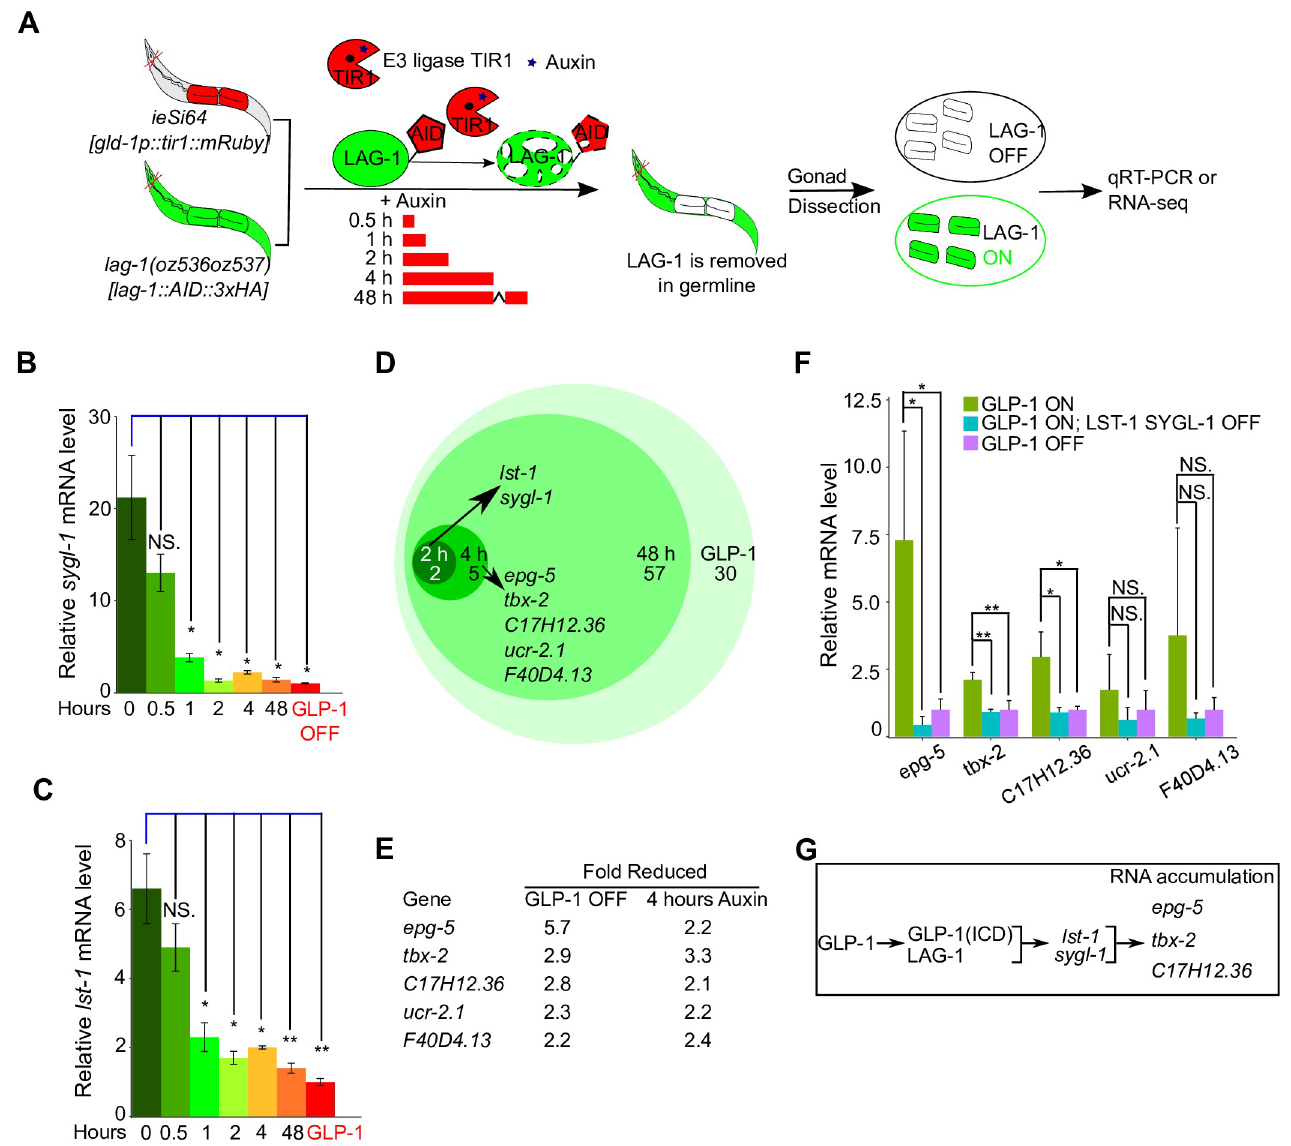
Fig 7. Time-course transcriptomic analysis to identify LAG-1-dependent genes in the germline. (A) Schematic showing time-course qRT-PCR and transcriptomic analysis following germline-specific degradation of LAG-1. This strain harbors germline-expressed TIR1, an ubiquitin E3 ligase that drives degron containing target protein degradation through proteolysis in the presence of co-factor auxin [38]. The CRISPR allele lag-1(oz536oz537) has the AID degron fused to the C-terminus of LAG-1, which is recognized by TIR1, resulting in germline-specific degradation of LAG-1. The complete genotype for this strain is gld-2(q497) gld-1(q485); glp-1(ar202); lag-1(oz536oz537[lag-1 :: degron :: 3xHA]); ieSi64[gld-1p :: TIR1 :: mRuby :: gld-13'UTR] . Isolated gonads, after dissection, are used to quantitate the abundance of RNAs, either through qRT-PCR or transciptomic analysis. (B & C) Quantitation of two GLP-1/LAG-1 targets sygl-1 and lst-1 mRNA abundance after auxin treatment at different time points. Three biological replicates were conducted and two-tailed t-test was used for statistical analysis. P-value � 0.01 ( � ); � 0.001 ( �� ); � 0.0001 ( ��� ); > 0.01 non-significant (NS.). (D) Venn diagram showing genes whose RNA expression is dependent on LAG-1 at the various time points through transcriptomic analysis. Genes observed at an earlier time are also dependent at later time point(s), but not shown for simplicity. The presented genes were also controlled by GLP-1. Four biological replicates were conducted for each time point. (E) Expression of 5 genes was reduced after 4 hrs auxin treatment, in addition to lst-1 and sgyl-1 (identified at 2 hrs auxin treatment). Shown are the genes’ relative fold reduction in both GLP-1 OFF and LAG-1 OFF (via 4 hrs auxin treatment) from transcriptomic analysis. (F) qRT-PCR analysis for genes expression level from (E) in different mutant backgrounds. The genotypes are, GLP-1 ON : gld-2(q497) gld-1(q485); glp-1(ar202) . GLP-1 OFF : gld-2(q497) gld-1(q485); glp-1 (q175) . GLP-1 ON LST-1 SYGL-1 OFF : gld-2(q497) gld-1(q485) lst-1(ok814) sygl-1(tm5040); glp-1(ar202) . Five biological replicates were conducted for each genotype and two-tailed t-test was used for statistical analysis. P-value � 0.01 ( � ); � 0.001 ( �� ); � 0.0001 ( ��� ); > 0.01 non-significant (NS.). (G) Model depicting genetic control of RNA accumulation for genes from (F). See S6 and S7 Tables